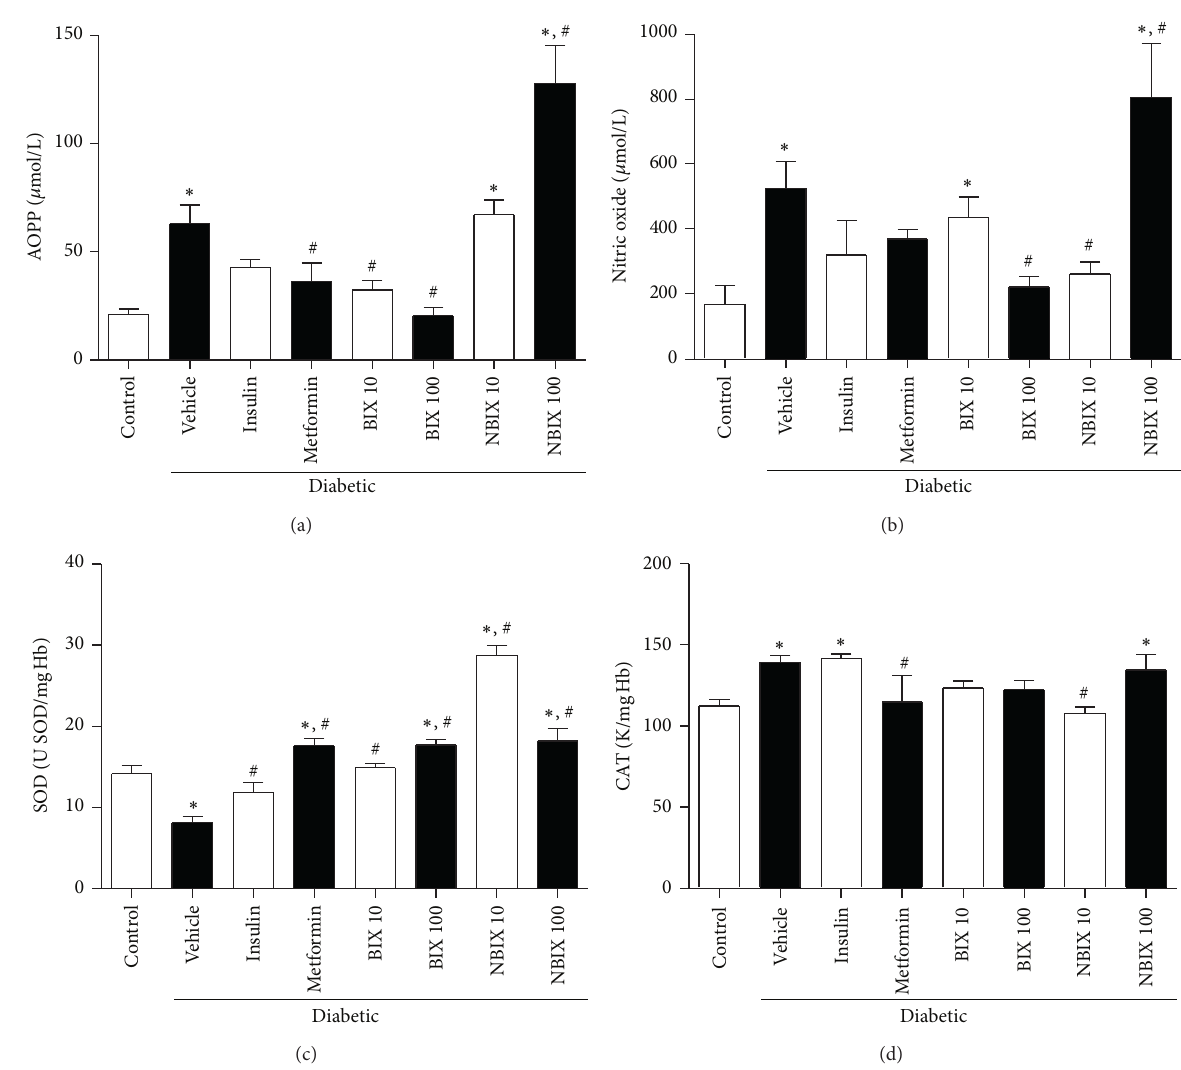
Figure 4: Oxidative stress parameters of streptozotocin-induced diabetic rats: AOPP levels (a), nitric oxide levels (b), superoxide dismutase (SOD) (c), and catalase activity (CAT) activity (d). Data are expressed as mean ± SEM ( 𝑛 = 6 per group). ANOVA followed by Duncan’s test: ∗ 𝑃 < 0.05 versus nondiabetic control; # 𝑃 < 0.05 versus diabetic vehicle. BIX 10:10mg/kg bixin; BIX 100: 100mg/kg bixin; NBIX 10:10 mg/kg norbixin; NBIX 100:100 mg/kg